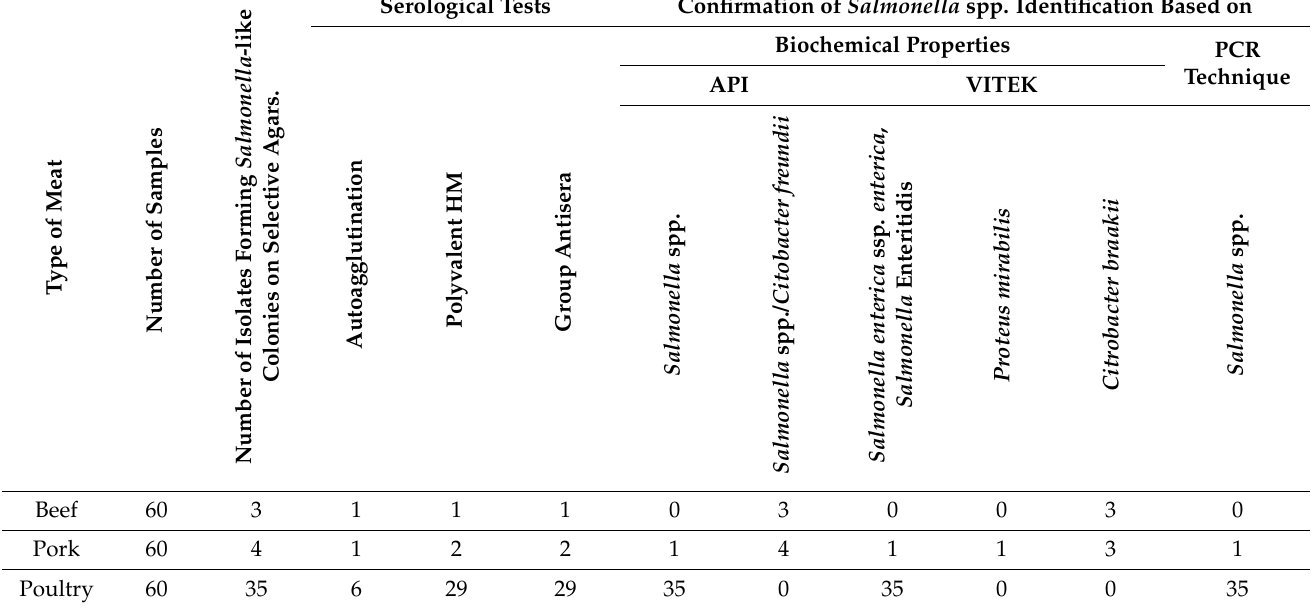
Table 2. Identification of Salmonella spp. isolates obtained from meat samples based on colony morphology on selective agars, biochemical properties, and the PCR technique. Serological Tests Confirmation of Salmonella spp. Identification Based on Biochemical